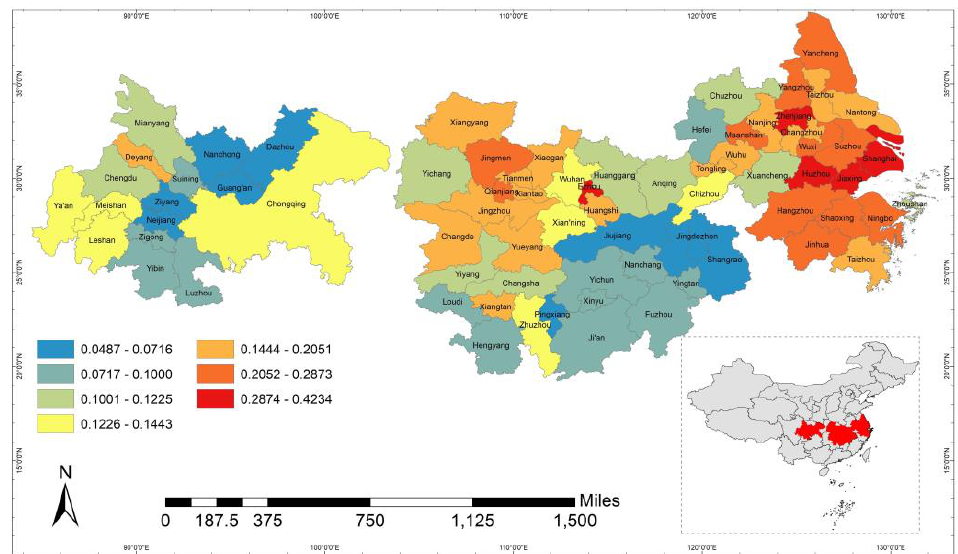
Figure 3. Per capita water ecological footprints of the three major urban agglomerations in the Yang- tze River Economic Belt in 2019. Yangtze River Economic Belt in